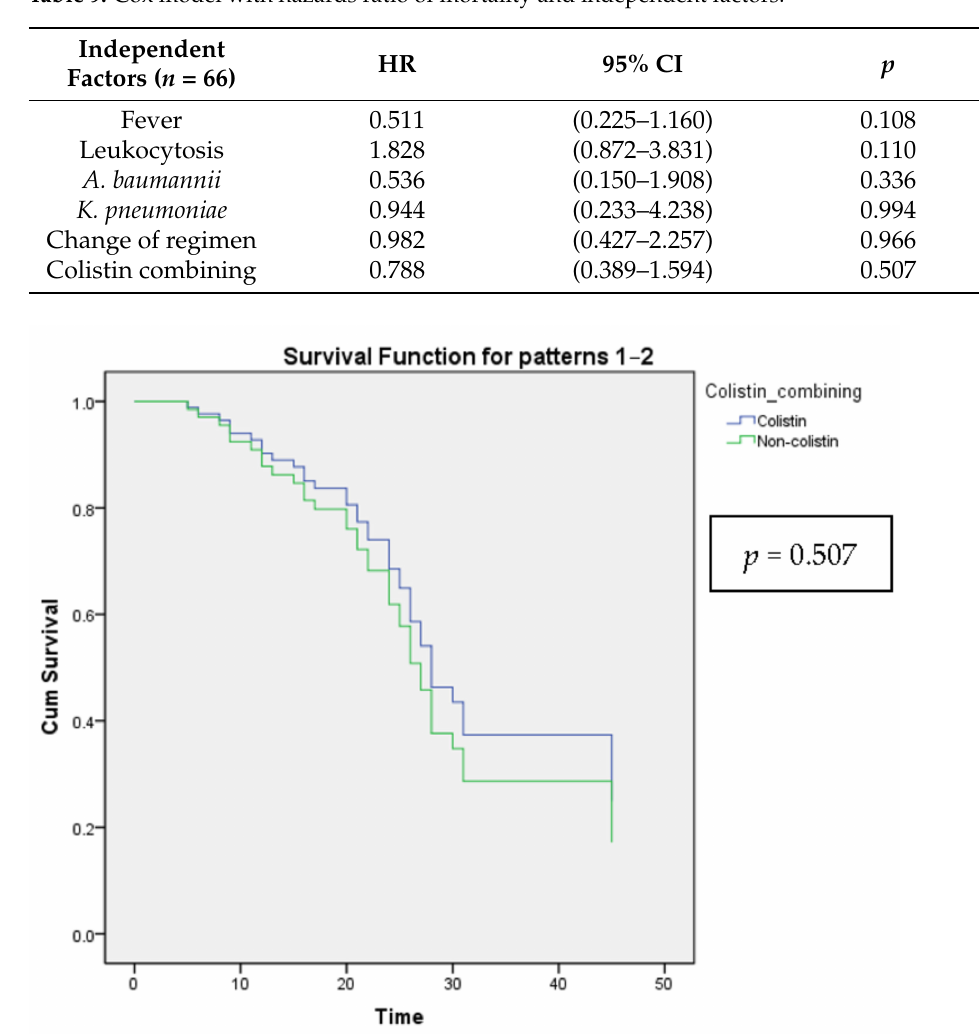
Table 9. Cox model with hazards ratio of mortality and independent factors.